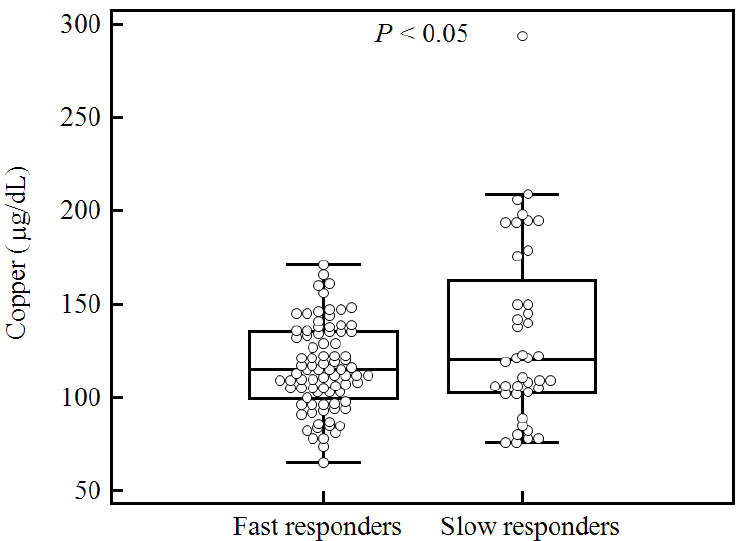
Figure 3. Comparison of serum copper levels at the time of diagnosis between fast responders and slow responders defined by the culture-positive and culture-negative results after one month of standard antituberculosis therapy.